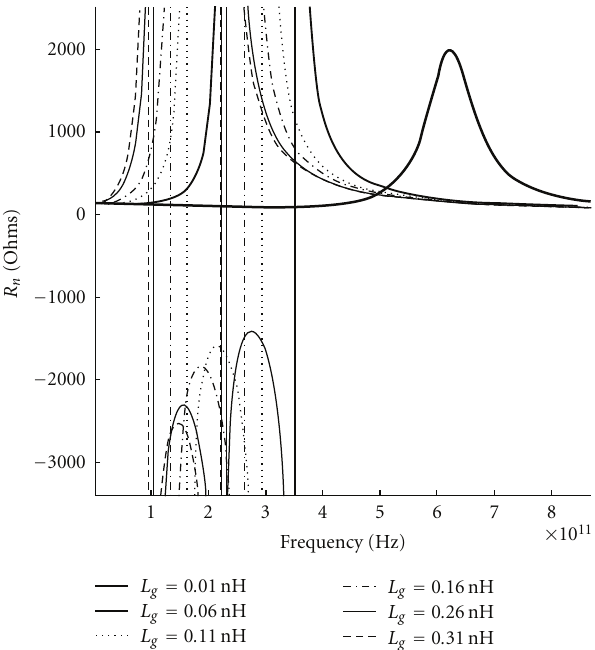
Figure 5: Variation of R n with gate-to-ground inductance L g